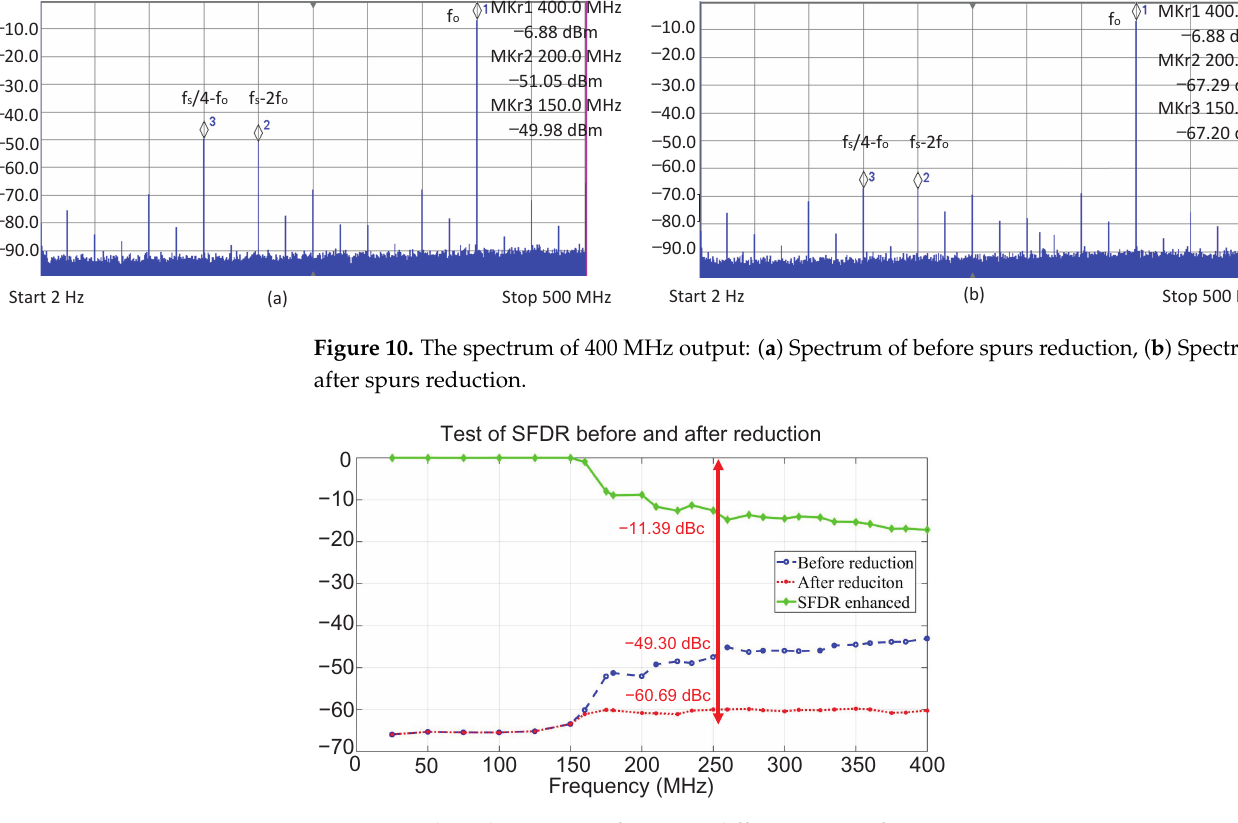
Figure 11. The enhancement of SFDR at different output